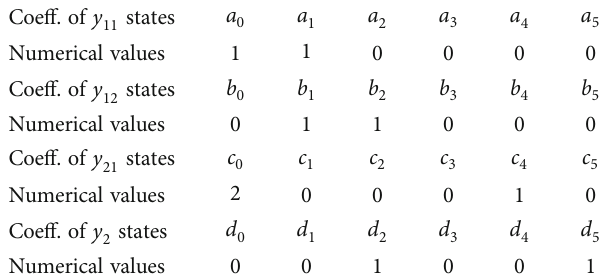
ð t Þ , y ð t Þ 1 2